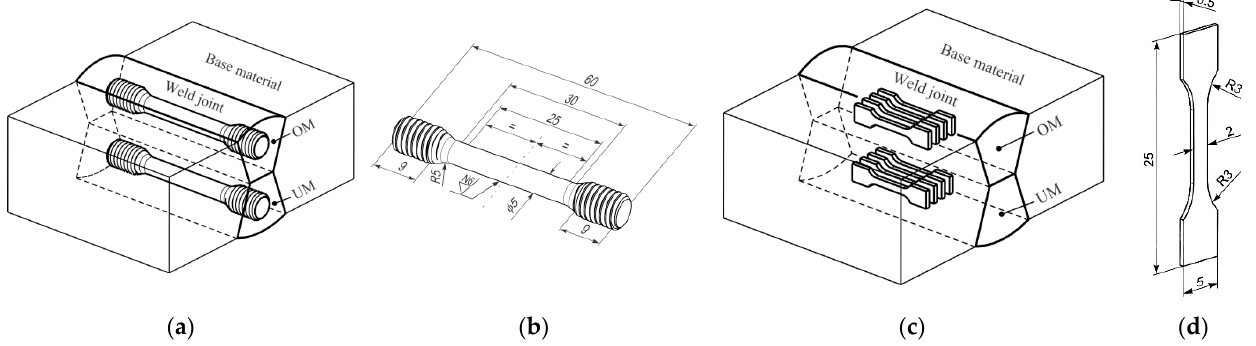
Figure 2. Positions of tensile specimens in weld joint and geometry of MTSs: ( a ) orientation and position of round tensile specimen in weld metal; ( b ) round specimen geometry; ( c ) orientation and position of set of mini tensile specimens in weld metal; ( d ) mini tensile specimen geometry.